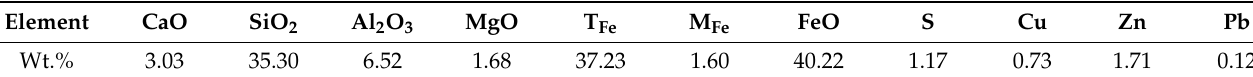
Table 1. The composition of copper slag.